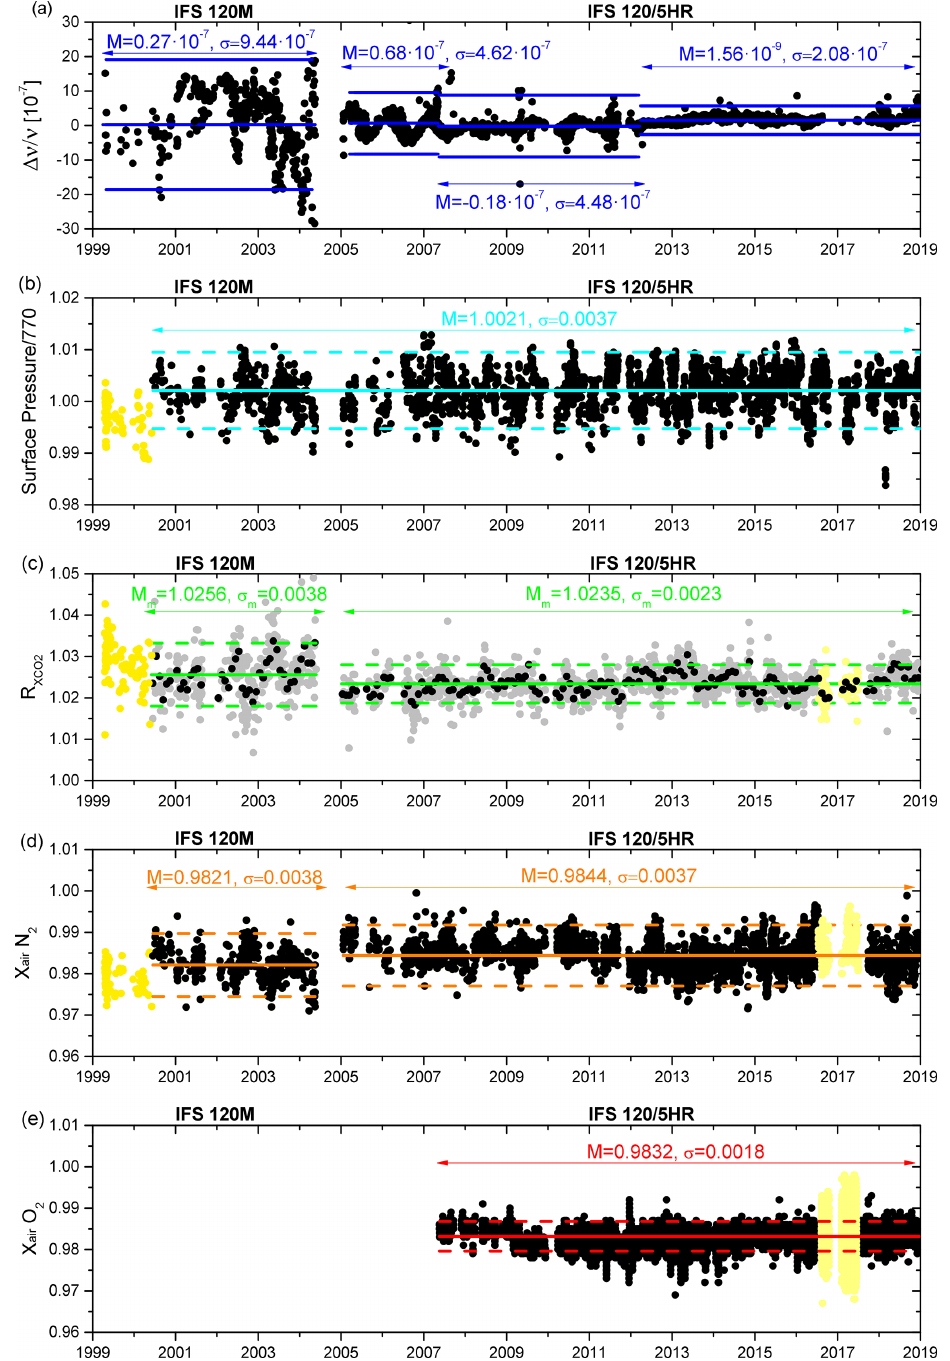
Figure 6. Time series of (a) Doppler spectral scaling factor (cid:49)ν/ν estimated from measured MIR spectra around 2104cm − 1 solar line; (b) surface pressure (normalized by typical surface pressure at IZO of 770hPa); (c) R X CO ratio (see definition in the text); (d, e) X air N 2 2 and X air O 2 parameters, calculated using N 2 TCs from the NDACC FTIR spectra and O 2 TCs from the TCCON FTIR spectra, respectively. M m and σ m stand for mean and standard deviation values computed from the monthly time series in (c) , while M and σ refer to the same statistics, but based on single measurements in (d) and (e) . The period marked with yellow dots in (b) , (c) , and (d) denotes instrumental issues on surface pressure records between 1999–2000 and has been ruled out to compute the statistics displayed in the sub-plots. Light-yellow dots in (d) correspond to the 2016–2017 period, when frequency instabilities were detected in the FTIR internal reference laser. Solid and dashed lines represent mean values and ± 2 σ ranges,